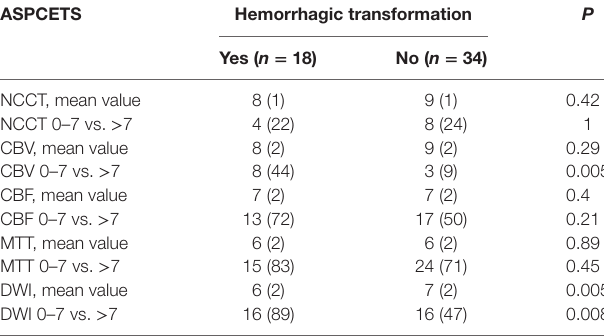
Table 3 | Comparison of the ASPECTS for HT versus non-HT, using t -tests and dichotomous ASPECTS cut point. asPceTs